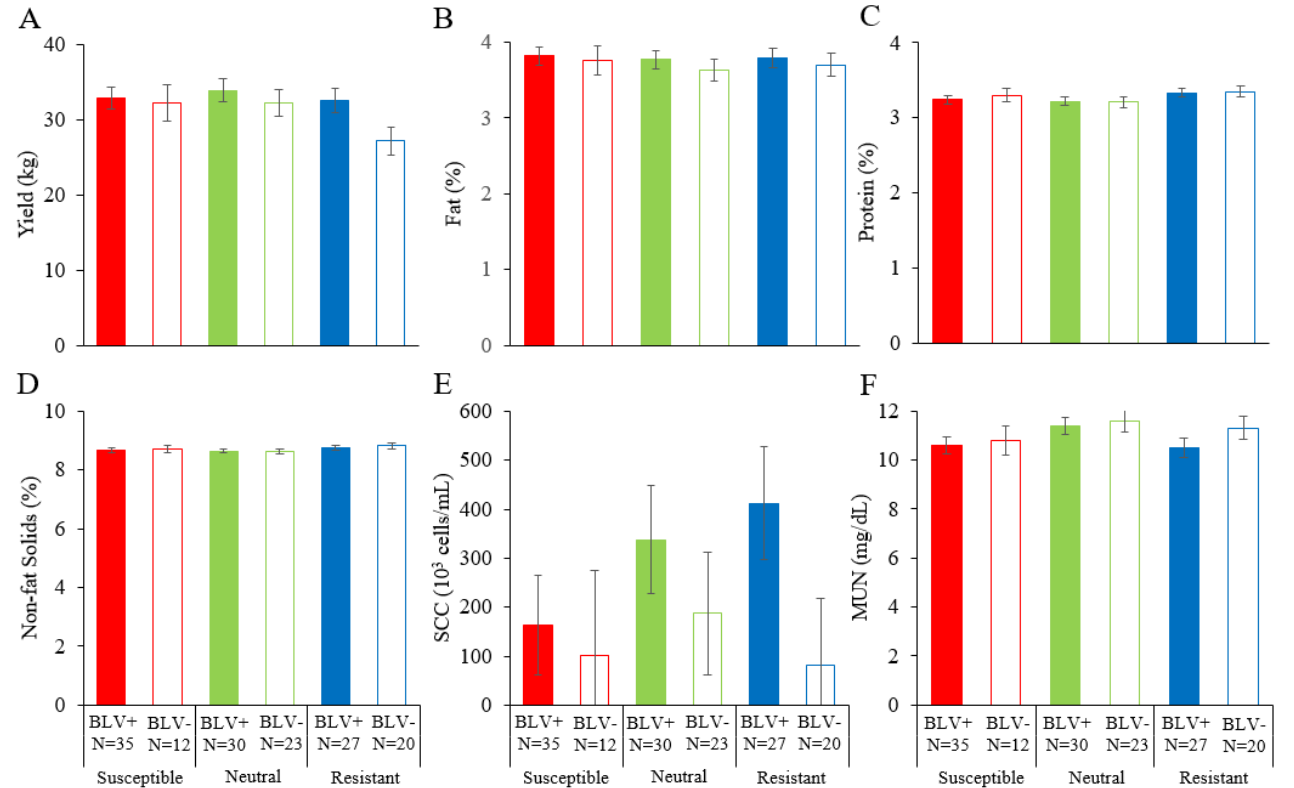
Figure 4. Effects of both BLV infection and BoLA-DRB3 on dairy cattle productivity (( A ) yield (kg), ( B ) fat (%), ( C ) protein (%), ( D ) non-fat solids (%), ( E ) SCC (10 3 cells/mL), and ( F ) MUN (mg/dL)).